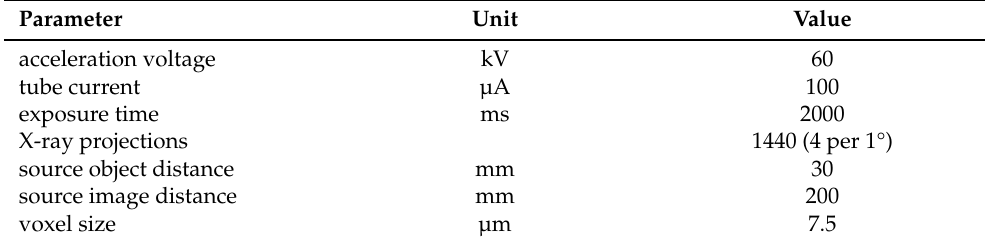
Table 2. Test specification for CT analysis of initial prepreg